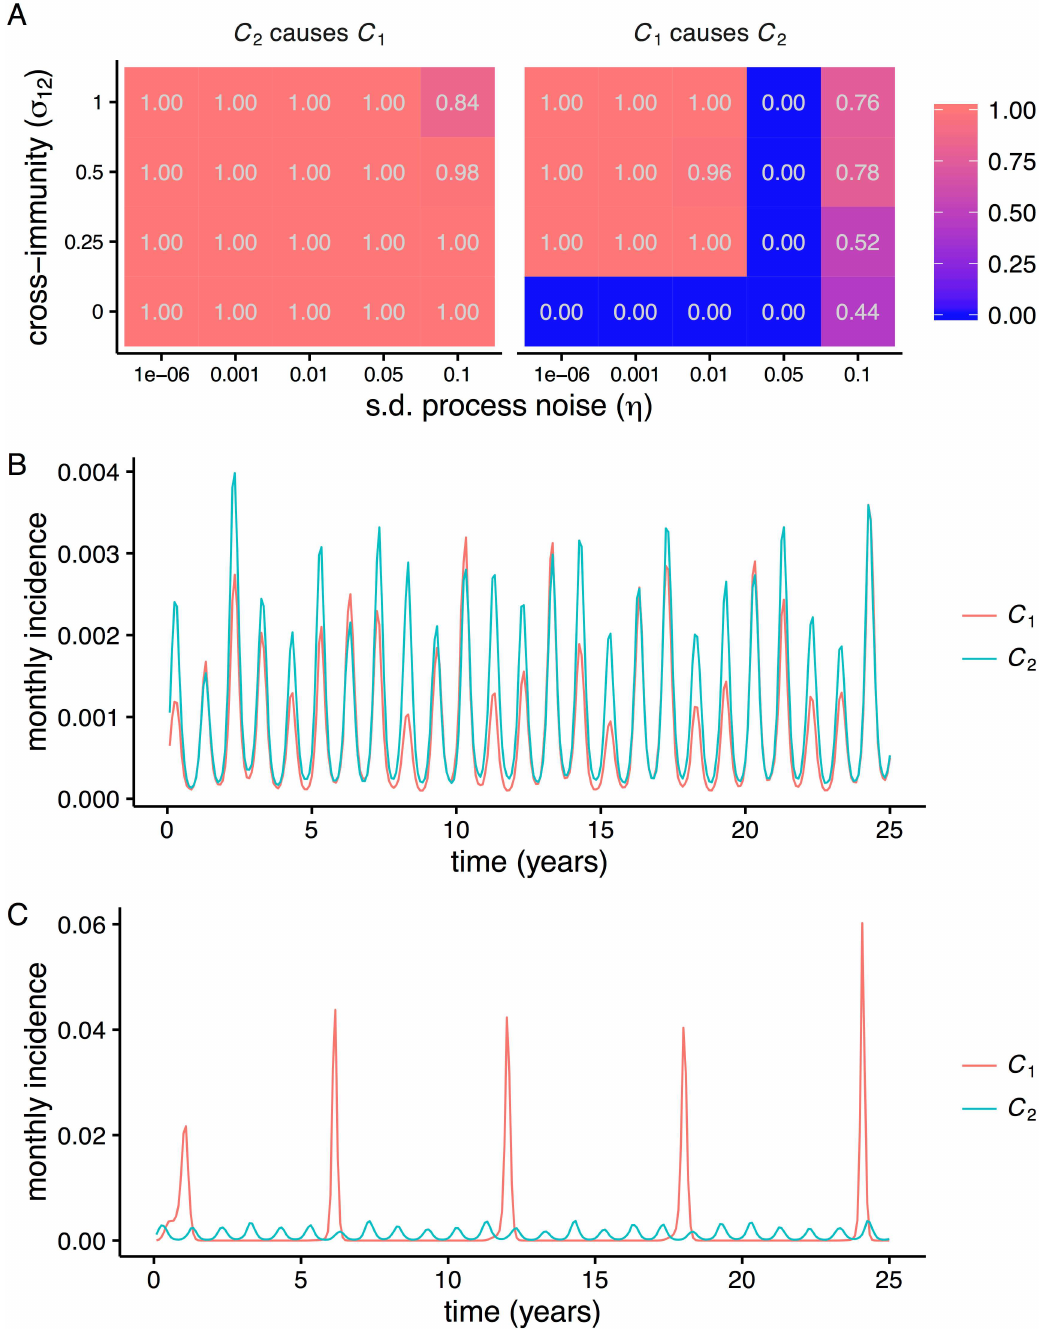
Fig 2. Interactions detected as a function of process noise and the strength of interaction ( C 2 ! C 1 ) and representative time series. (A) Heat maps show the fraction of 100 replicatessignificantfor each inferred interaction for different parameter combinations. A significantincrease in cross-map correlation ρ with library length L indicateda causal interaction. The time series consisted of 1000 years of monthlydata. (B) Representative 25-year sample of the time series for which mutual interactions were inferred ( σ 12 = 0.25, η = 0.01). (C) Representative sample of the time series for which C 2 is inferred to drive C 1 but not vice-versa( σ 12 = 0.25, η = 0.05).